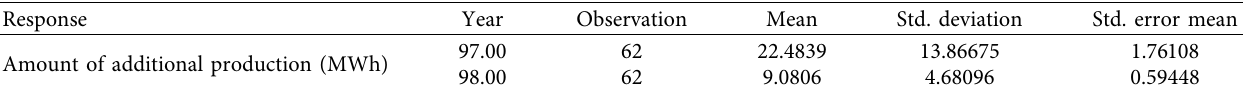
Table 17: SPSS software outputs regarding the different tests of the average amount of overproduction. Levene’s test Treatment